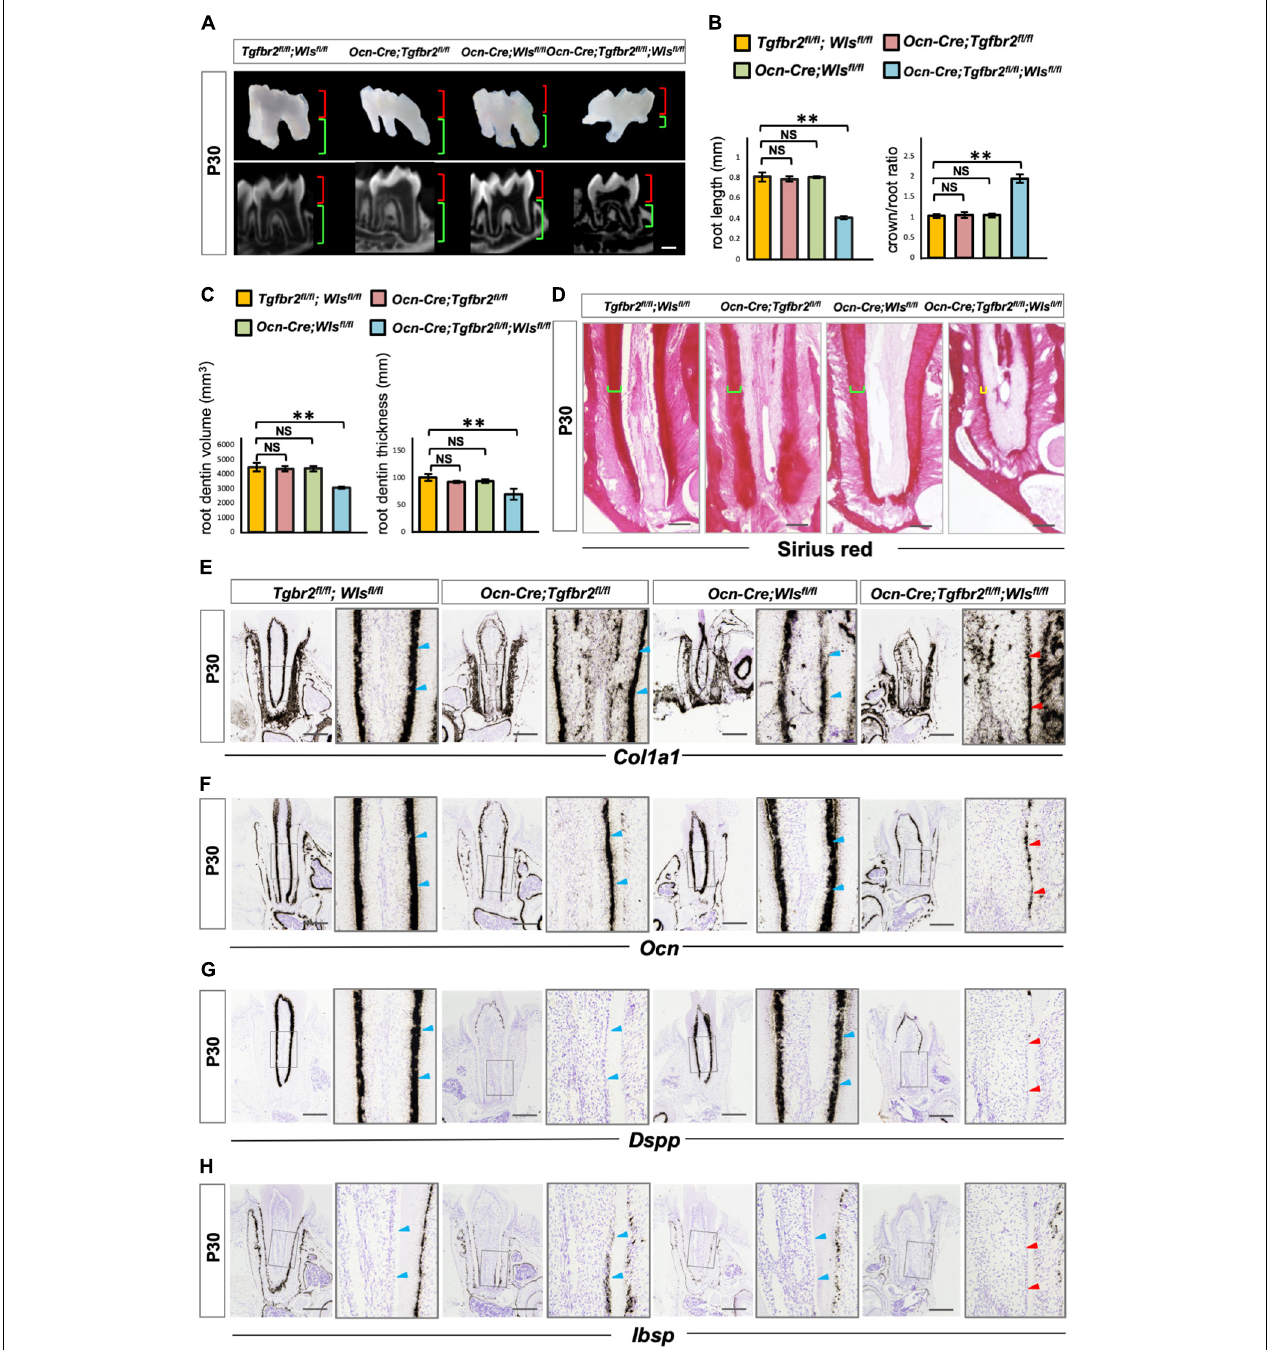
FIGURE 4 | Arrested root odontoblast differentiation in Ocn-Cre ; Tgfbr2 fl / fl ; Wls fl / fl mice. (A,B) Significant short molar roots in Ocn-Cre ; Tgfbr2 fl / fl ; Wls fl / fl mice compared to Tgfbr2 fl / fl ; Wls fl / fl mice, Ocn-Cre ; Tgfbr2 fl / fl mice and Ocn-Cre ; Wls fl / fl mice at P30. Data are presented as the means ± standard deviation (SD). ** P < 0.01, n = 4 mice/per genotype. (C,D) Reductions in root dentin volume and dentin thickness in Ocn-Cre ; Tgfbr2 fl / fl ; Wls fl / fl mice at P30. Data are presented as the means ± standard deviation (SD). ** P < 0.01, n = 4 mice/per genotype. (E,F) Expression of osteo/odontogenic differentiation markers is sharply reduced in Ocn-Cre ; Tgfbr2 fl / fl ; Wls fl / fl mice at P30 ( n = 4 mice/per genotype). (G,H) Diminished expression of Dspp and Ibsp in root odontoblasts of Ocn-Cre ; Tgfbr2 fl / fl ; Wls fl / fl mice at P30 ( n = 4 mice/per genotype). Blue arrowheads indicate expression of differentiation markers in Tgfbr2 fl / fl ; Wls fl / fl mice, Ocn-Cre ; Tgfbr2 fl / fl mice and Ocn-Cre ; Wls fl / fl mice, red arrowheads indicate sharp reduction in expression of differentiation markers in Ocn-Cre ; Tgfbr2 fl / fl ; Wls fl / fl mice. The right panels show the high-magnification image of the area boxed in gray on the left in (E–H) . NS, non-significant. Scale bars: 300 µ m (A) , 50 µ m (D) , 100 µ m (E–H) .